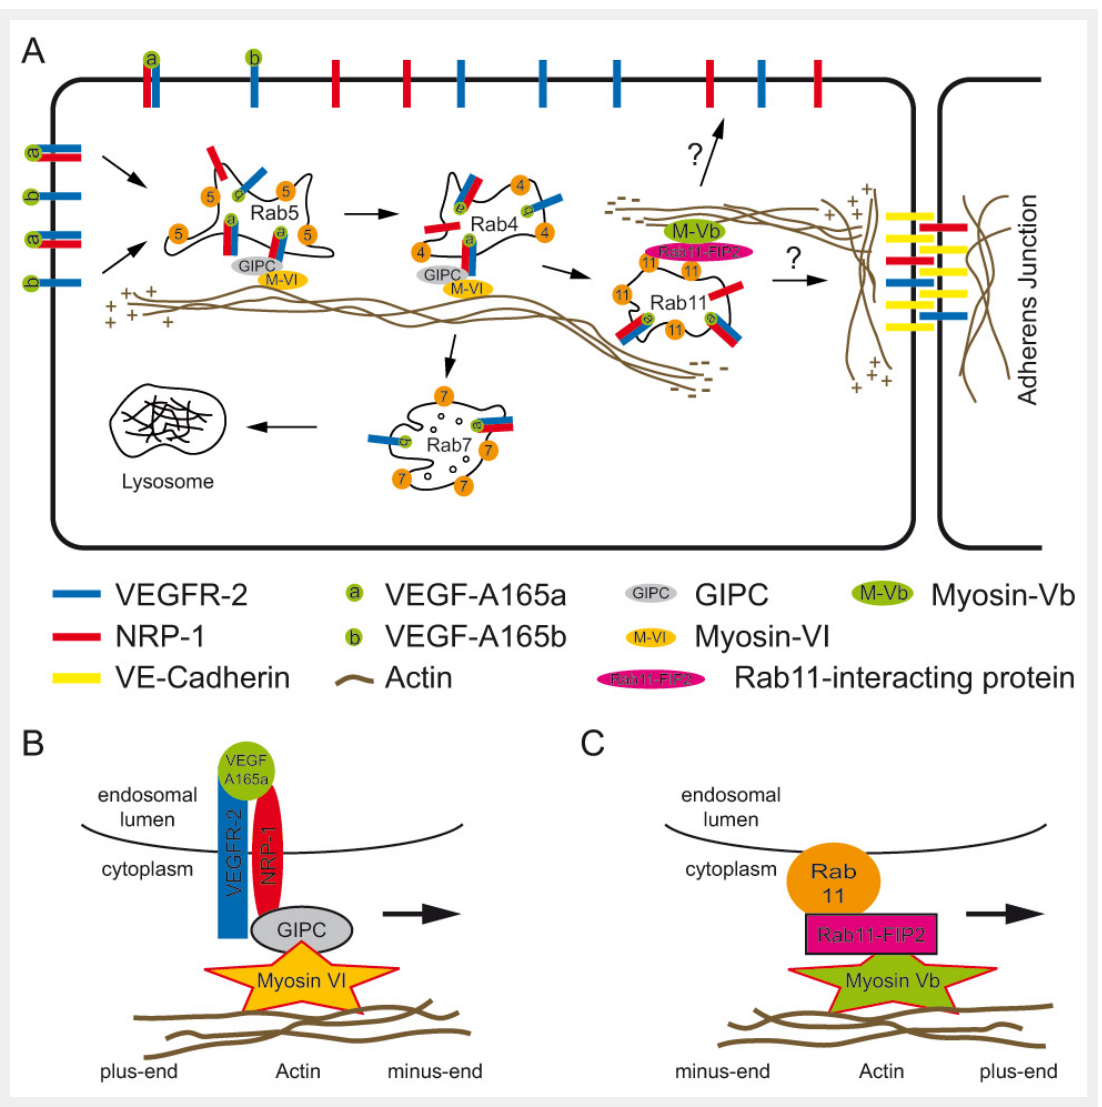
Figure 2 Influence of NRP-1 on VEGFR-2 trafficking. (A) VEGF A165a links NRP-1 to VEGFR-2 leading to internalisation of the complex. NRP-1 rapidly recruits GIPC and myosin VI, a minus-end- directed actin motor. It is unclear how long this complex is active. We assume that it transports the complex to Rab11 vesicles since NRP-1 is necessary for the Rab4 to Rab11 transition. Recycling needs a plus-end-directed myosin motor such as for example myosin Vb, which indirectly interacts with Rab11. The insertion site at the plasma membrane is not known. The recycled factor can either contribute to the free VEGFR-2 pool on the plasma membrane or it can be inserted into adherens junctions. VEGFR-2 bound to VEGF A165b is preferentially routed via Rab5, Rab4, and Rab7 to lysosomes or proteasomes. (B) Detailed view of the minus-end-directed myosin complex. (C) Detailed view of a plus-end- directed myosin complex. Note that suggested role in angiogenesis of the complex shown is not proven